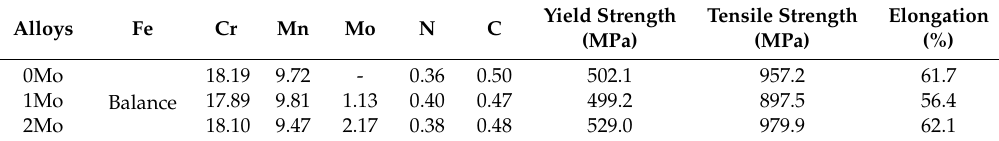
Yield Strength Tensile Strength Elongation (MPa) (MPa) (%)